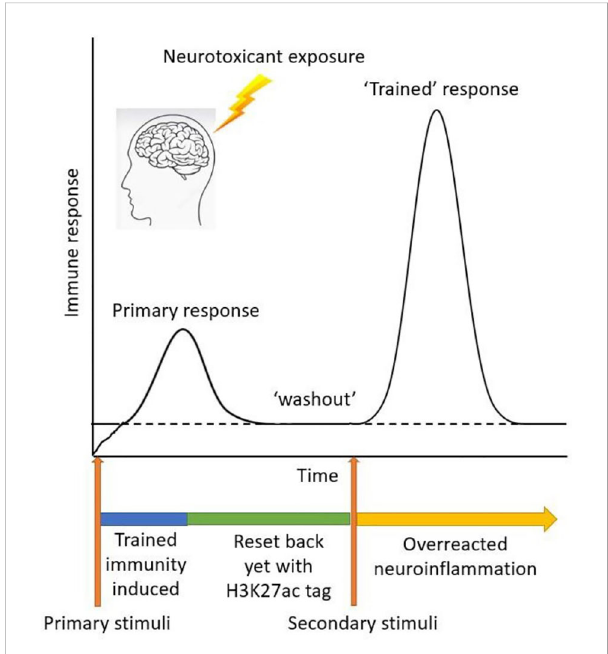
FIGURE 6 Schematic diagram of trained immunity treatment paradigm using LPS as a primary memory trigger and Mn as a secondary environmental